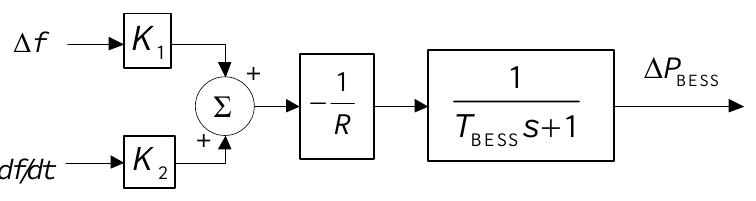
Figure 10. Simplified model of virtual inertia controller implemented in the BESS.